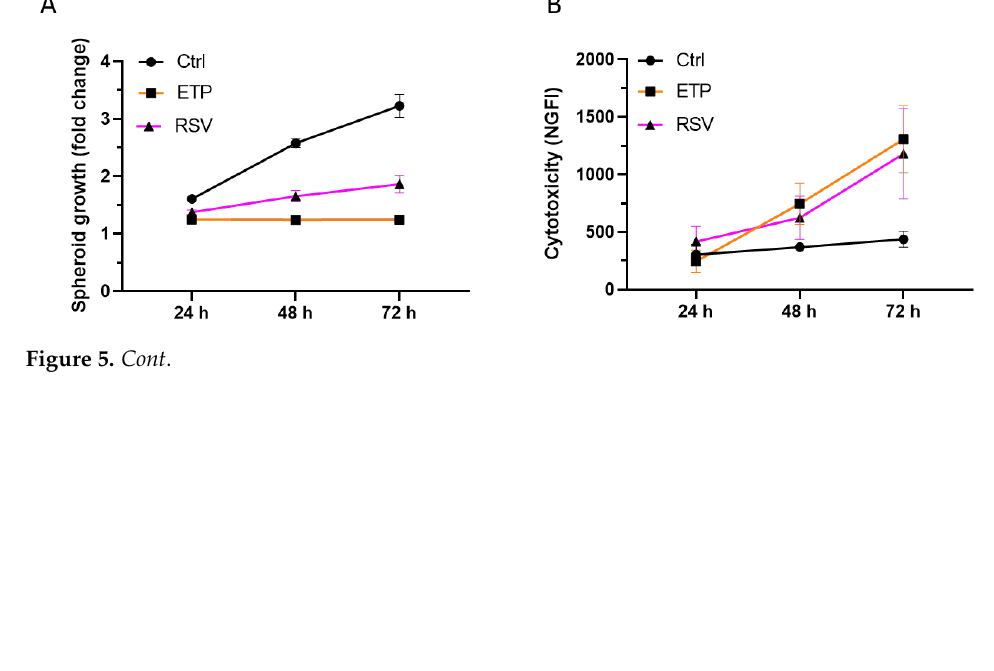
Figure 5. MIM-4 could act as an adjuvant when associated with etoposide or resveratrol, in an in vitro 3D-spheroid model of CRC. ( A ) Spheroids were cultivated in standard conditions and treated for 24, 48 or 72 h with either ETP (orange curve) or RSV (pink curve), at 50 µM each. Spheroids cultivated in standard conditions without any treatment were used as a positive control (Ctrl). Spheroid volumes were calculated and the growth evolution was represented as the fold change of the initial spheroid volume at the time of the treatment initiation. Results are presented as the growth mean ± SD for each condition ( n = 3). ( B ) The cytotoxicity of both ETP and RSV was appraised in the same conditions as described in ( A ). The results are presented as the mean normalized green fluorescence intensity (NGFI) ± SD from CellTox green fluorescent dye, for each condition ( n = 3). NGFI was calculated as described in Section 4.4.3. Spheroids were cultivated in the presence of RSV ( C ) or ETP ( D ) for 24, 48, or 72 h, concomitantly with either the Veh. (grey histograms) or MIM-4 (squared histograms) and the spheroid volumes were calculated in each condition. The results are presented as the mean ± SD of the volume percentage, the Veh. conditions